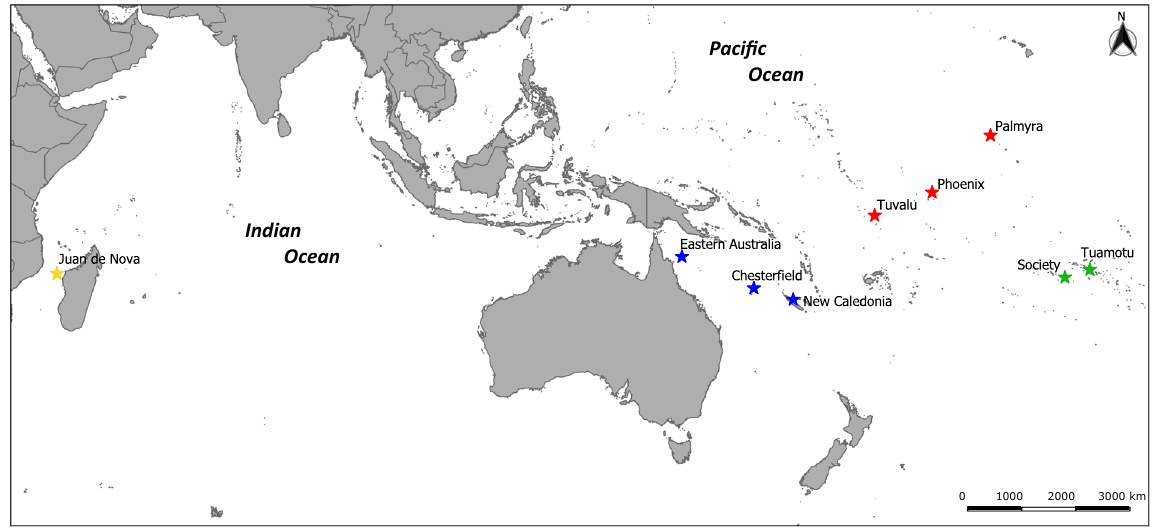
Figure 1. Map of the nine Indo-Pacific localities sampled for the 407 gray reef shark specimens analyzed in this study. The colors represent the genetic groups revealed in the